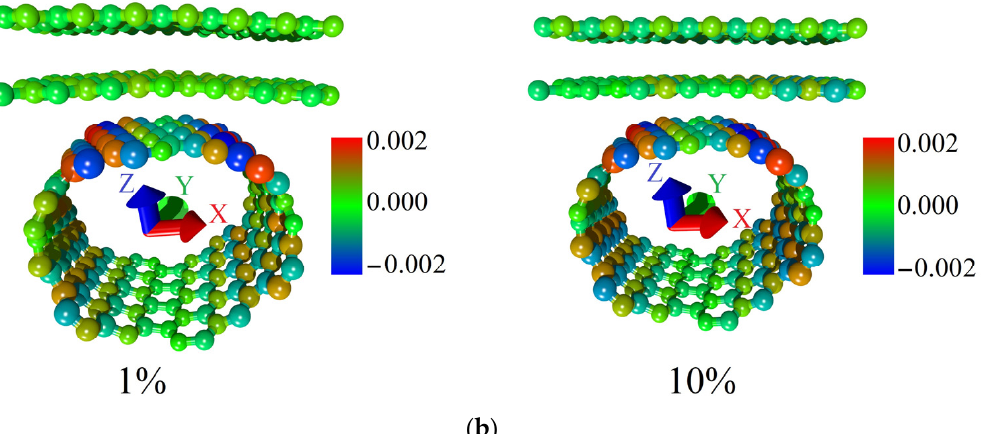
Figure 6. Distribution of the electron charge density over the supercell atoms of bilayer graphene- SWCNT (12,6) hybrid films with island topology for the cases of minimum and maximum allowable axial stretching: ( a ) model V1; ( b ) model V2.